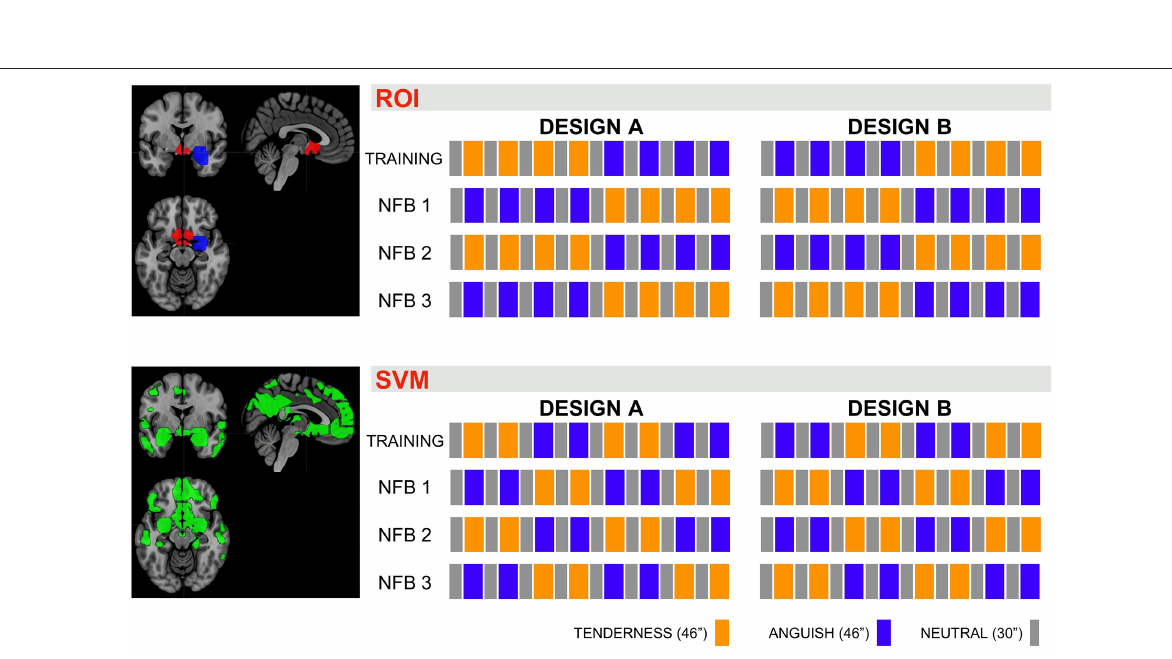
FIGURE 1 | Color hue modulation of the virtual environment during rtfMRI-NFB. The color hue changes from baseline neutral trials to a more intense orange and purple as participants increasingly engage target brain regions for tenderness and anguish trials.